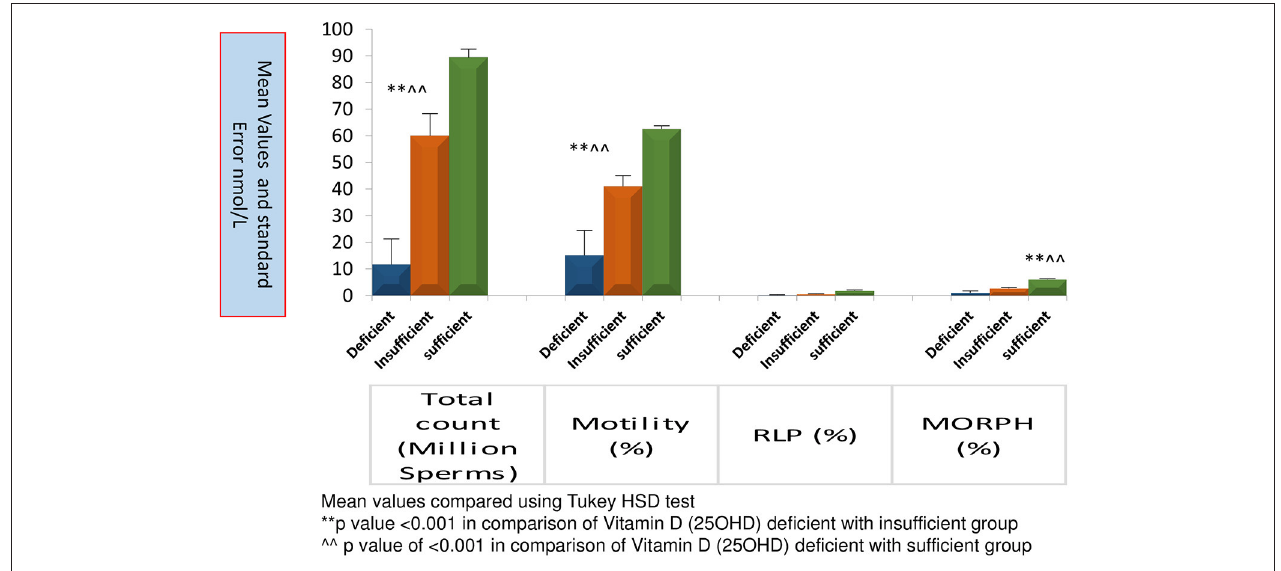
FIGURE 3 | Comparison of sperm parameters according to Vitamin D status. Mean value compared using Tukey HSD test.